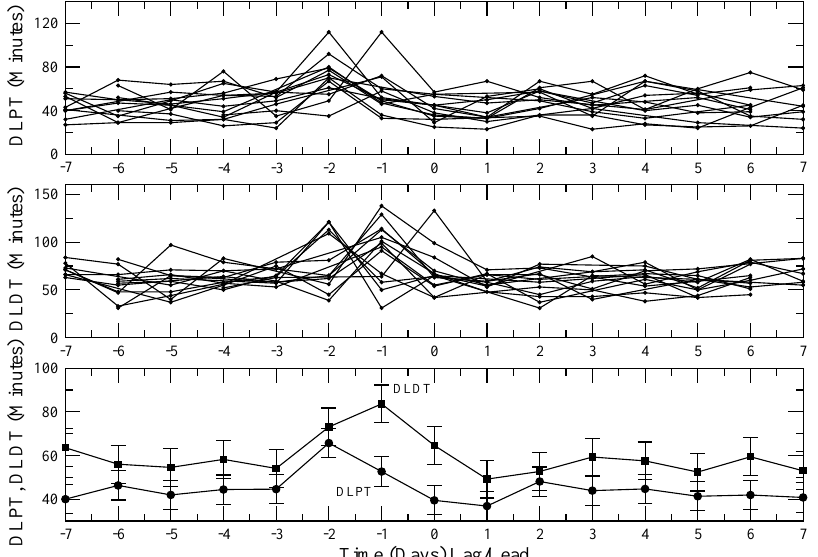
Fig. 6. The variation of the DLPT and DLDT as a function of days for a period of 15days around the seismic events. The first panel shows the variation of the DLPT and the second panel shows the variation of the DLDT. The zero of the X-axis indicates the day of 14earthquakes having M > 5. The third panel shows the average variation of the DLPT (filled circles) and DLDT (filled squares) obtained from the first two panels with standard deviations as error bars for those 14earthquakes. It is clear from the third panel that during the earthquakes, the value of DLPT is maximum on two days before the earthquakes and the value of the DLDT is maximum on one day before the earthquakes.